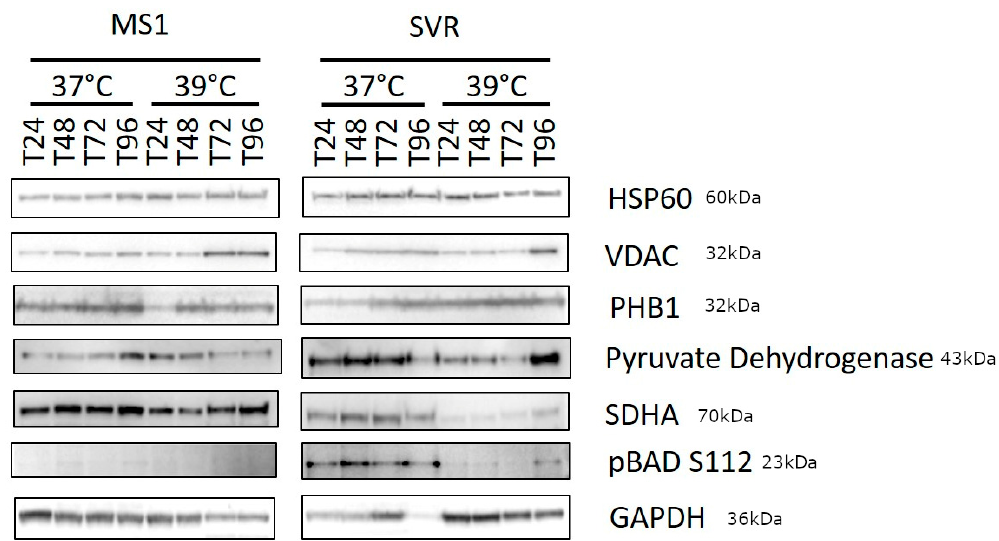
Figure 5. Western blot analysis conducted on MS1 and SVR cells under 37 ◦ C and 39 ◦ C for evaluating mitochondrial proteins. Temperature and hours of exposure are listed at the top of the representative Western blots. The identities of the proteins are given on the